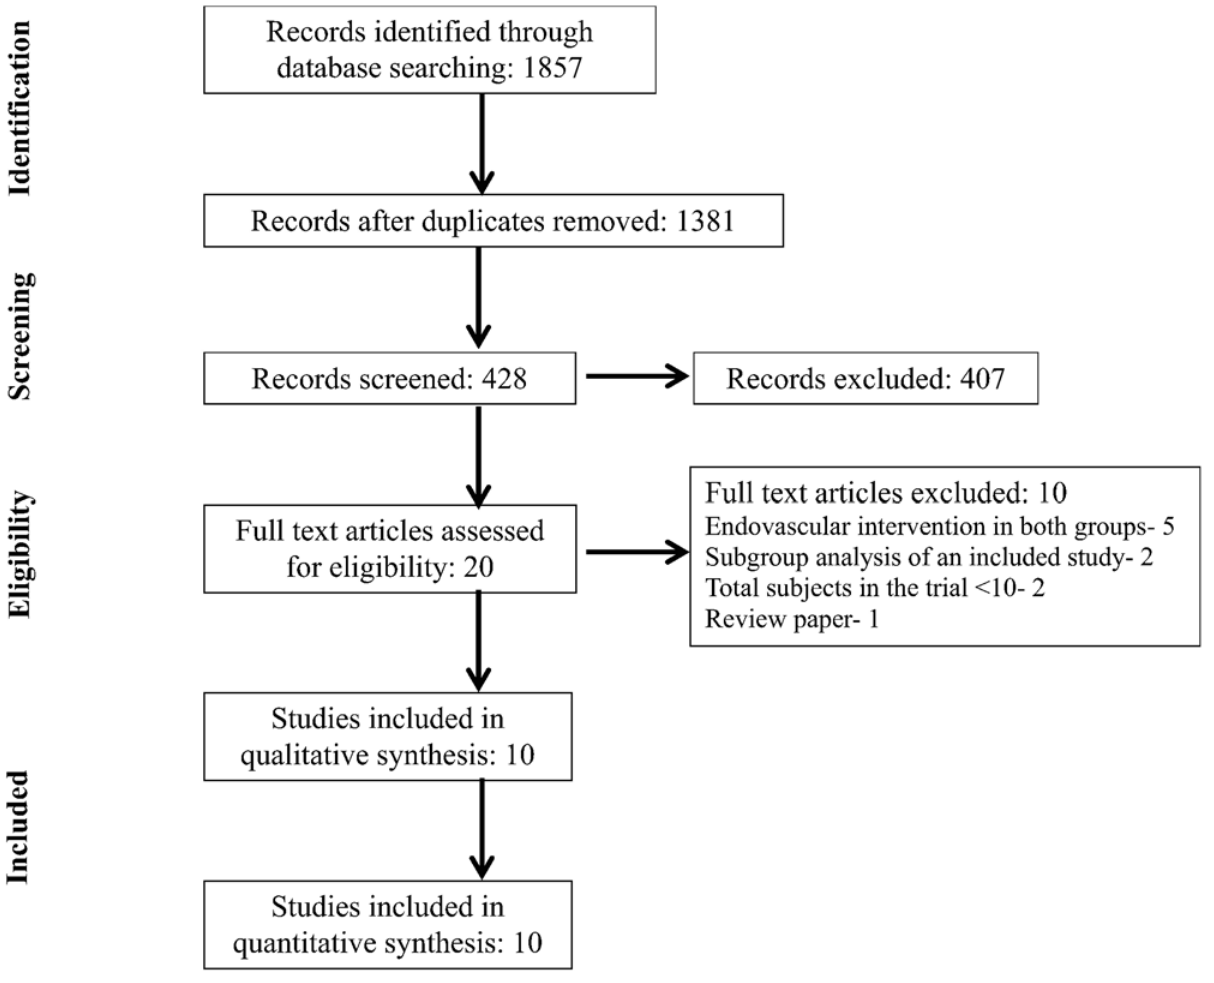
Fig 1. Flow diagram of selected